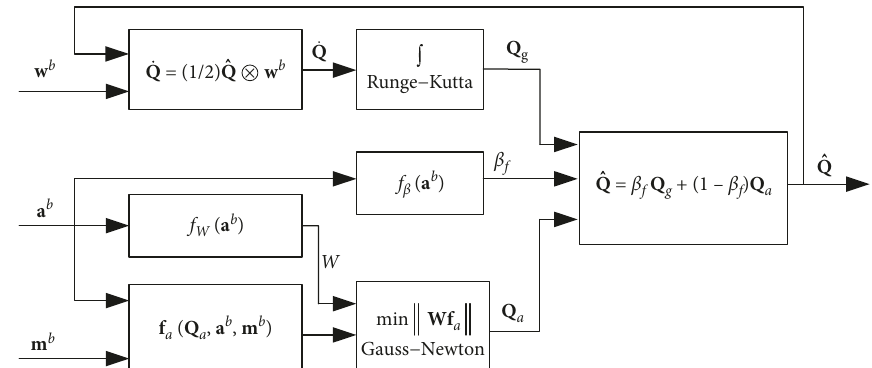
Figure 3: Principle of the attitude calculation